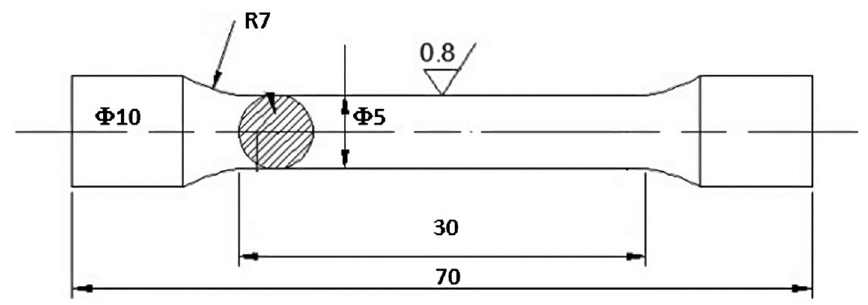
Table 2. chemical composition (wt).